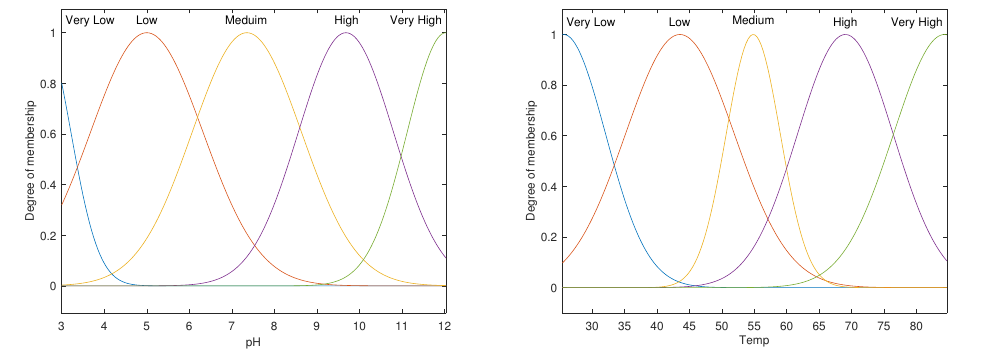
Figure 4. Memberships for pH and temperature.